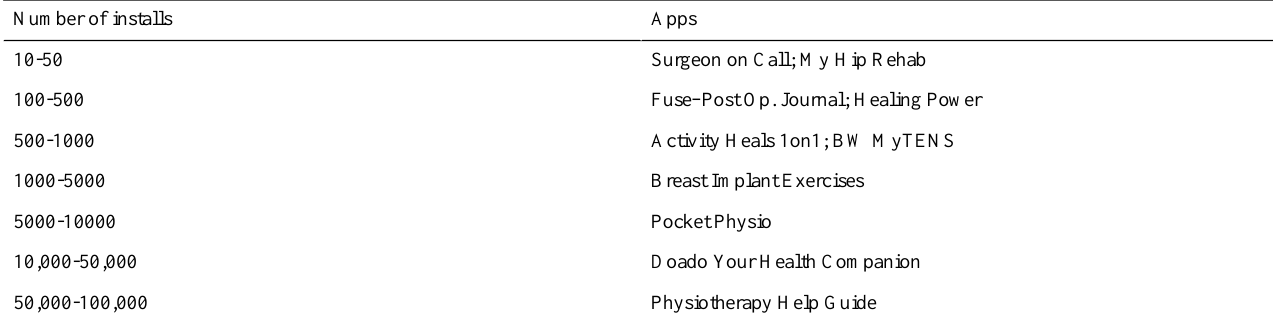
Table 2. App installations. Categories provided by Android Google Play Store. Data collected on April 26,